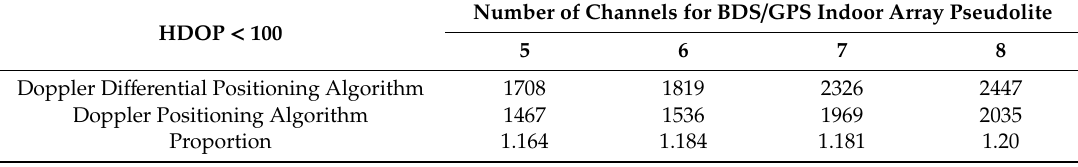
Figure 13. HDOP using Doppler differential positioning algorithm from channel 5 to channel 8.